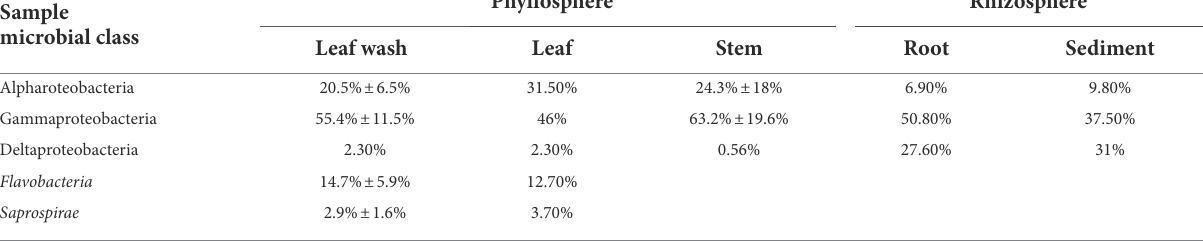
TABLE 2 Relative Abundance (±SD) of microbial classes in phyllosphere and rhizosphere samples of high-throughput amplicon sequencing of the 16S rRNA